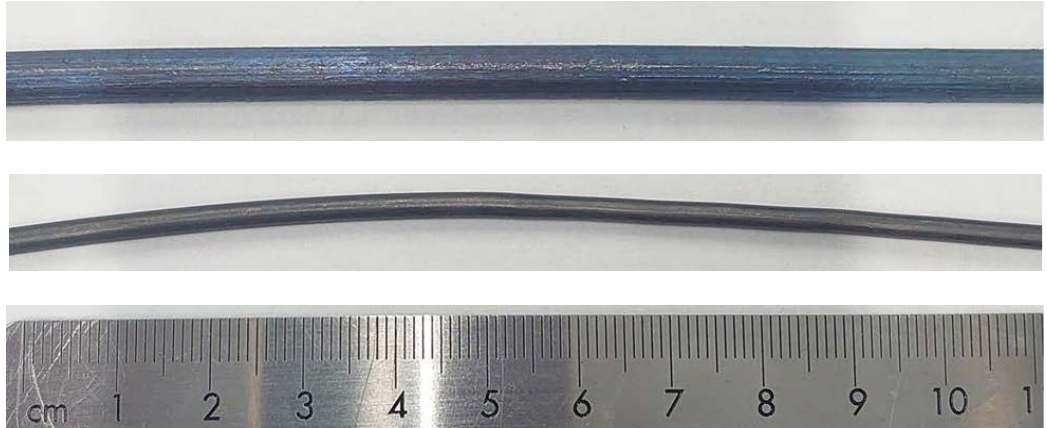
Figure 6. Photograph of as-Conformed CP-Ti Gr 2 wire with blue oxide film ( top ) and ø 3.00 mm cold-wire-drawn wire with bright surface ( bottom ) from the same extruded product.